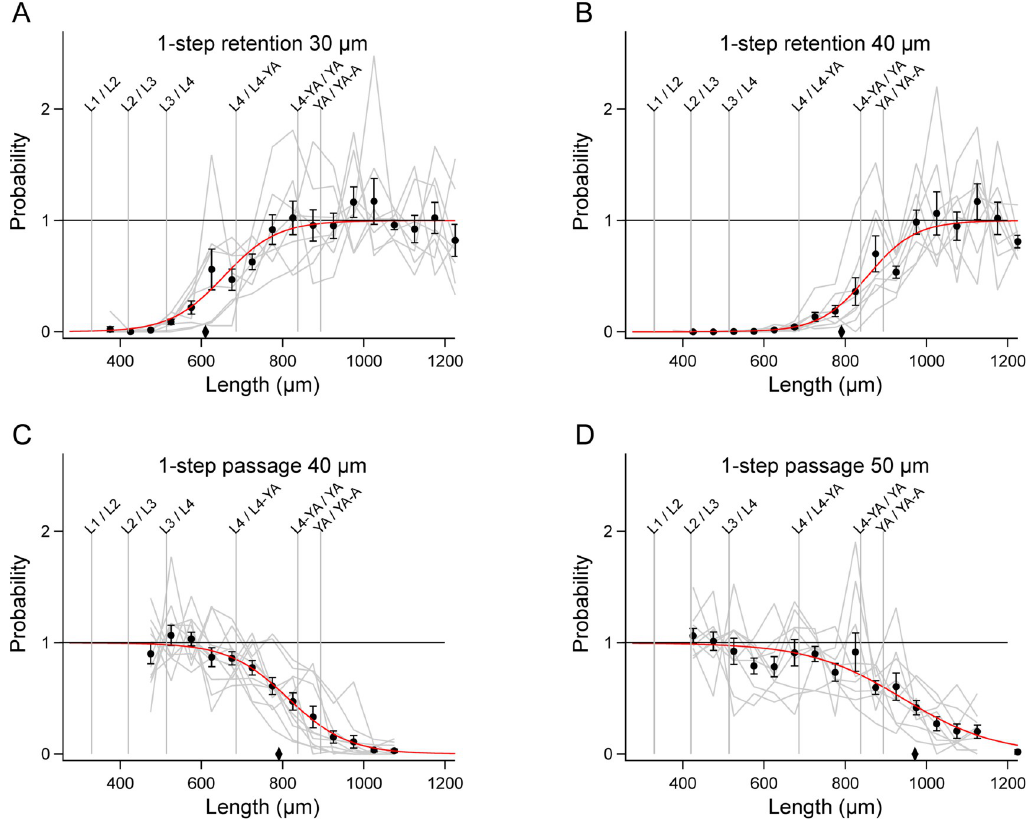
Fig 4. 1-step filter functions extracted from the data in Fig 3. A-D. Gray traces show the value of the ratio on the right-hand side of Eqs 2 and 3 for each run, after multiplication by the constant C (see text), such that the mean of data points in the asymptotic region is 1. Number of data points in the asymptotic region used to compute C is given in S1 Table. Black symbols indicate means of gray traces at each length. Error bars, SEM. Red traces are fits of Eq 4 or 4 to the means in each panel. Diamonds indicate the length of worms having a diameter equal to the mesh